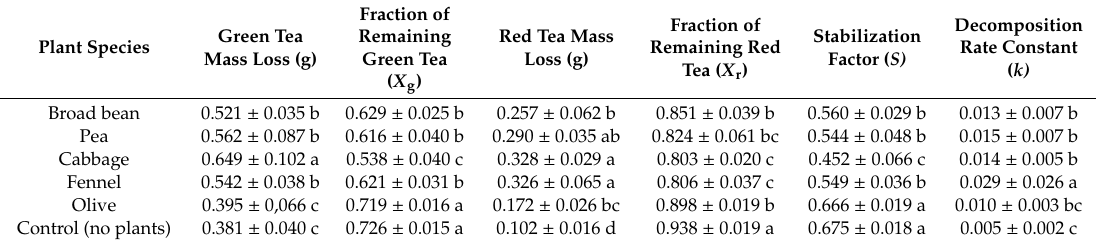
Table 2. Mass loss of green and red tea, fraction of remaining green ( X g ) and red tea ( X r ), stabilization factor ( S ), and decomposition rate constant ( k ) calculated from the green tea and red tea bags. Each value representsthemean( ± SD)offivereplicates(greentea / redteabagsfive; n = 5)foreachspecies. Thevalues followed by di ff erent letters (a–d) are statistically di ff erent ( p ≤ 0.01) within